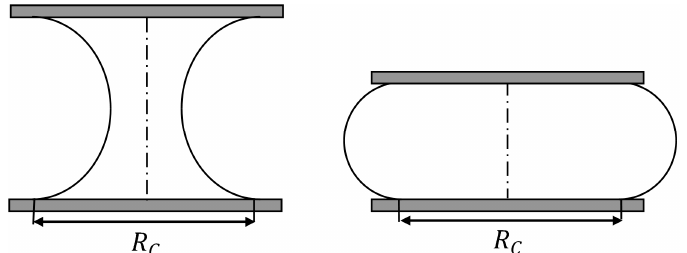
Figure 6. Schematic of the two extreme cases. Note that in both cases the contact line radii and volumes are equal. Only the gap between the platens and the contact angle have changed.